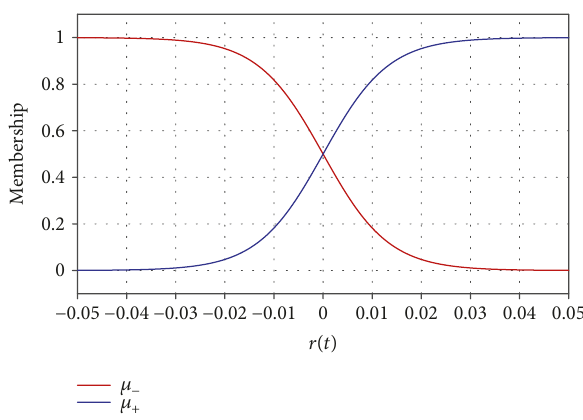
Figure 1: Membership functions with parameter α = 150 used for calculating discrete distributions of asset